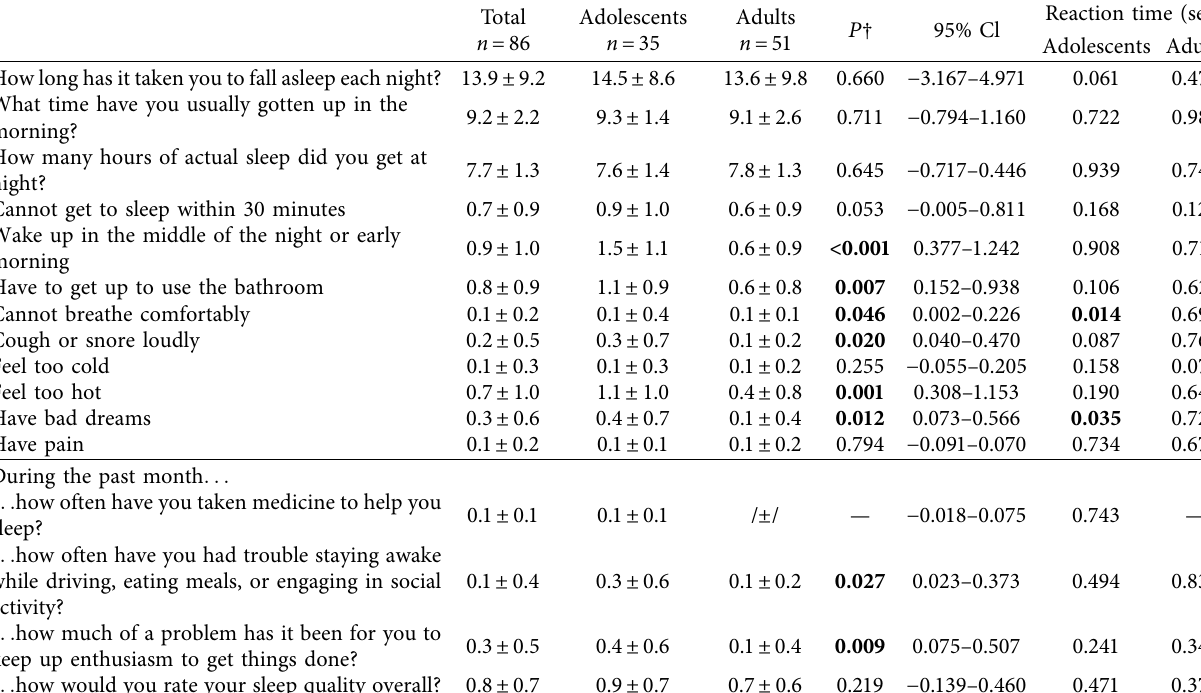
Table 2: Analysis between PSQI results and age group. Continuous variables are presented as mean ± standard deviation. The relationship between reaction time and age group is presented as P value.